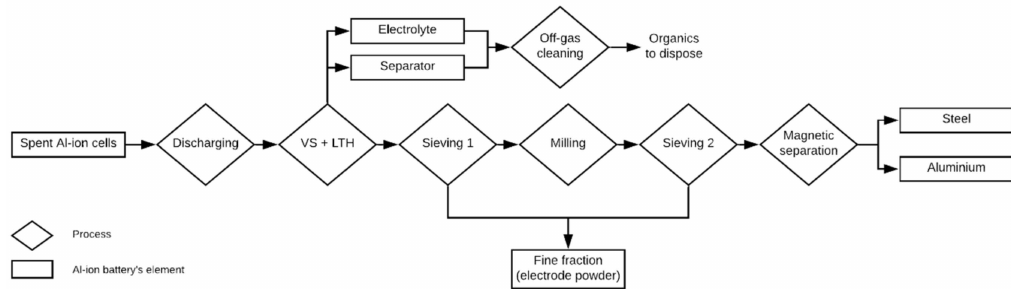
Figure 3. Flowchart of the novel Al-ion recycling process. The rhombuses represent the unit operations and the boxes represent the materials